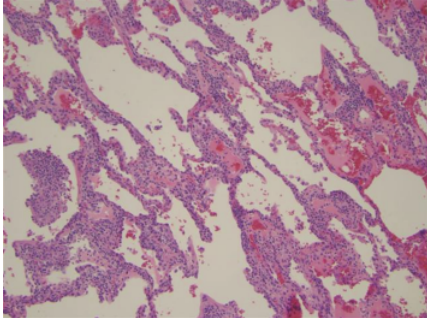
Figure 1: Computed tomography of the thorax showing extensive nodular, reticular, and groundglass opacities in both lungs along with mediastinal enlargement.